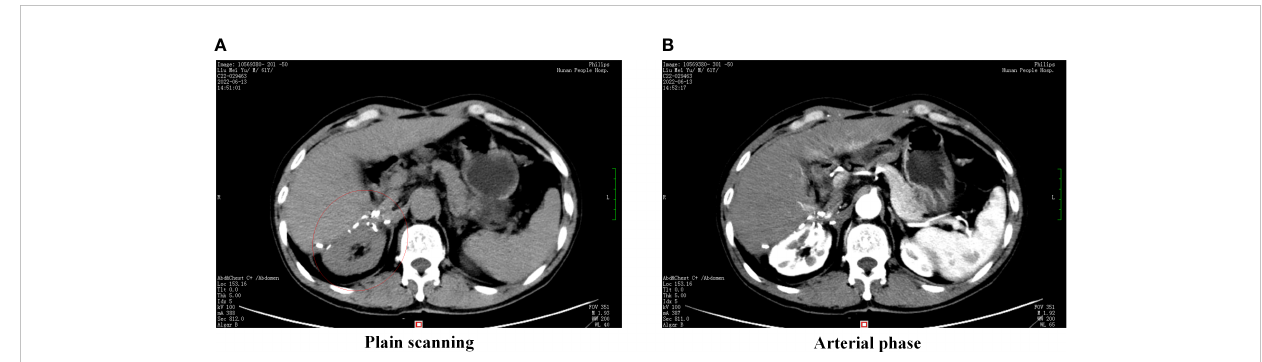
FIGURE 3 Postoperative abdominal CT. (A) CT scan in plain scanning, (B) CT scan in arterial phase. Postoperative abdominal CT images showed no new mass in the liver-kidney space (red